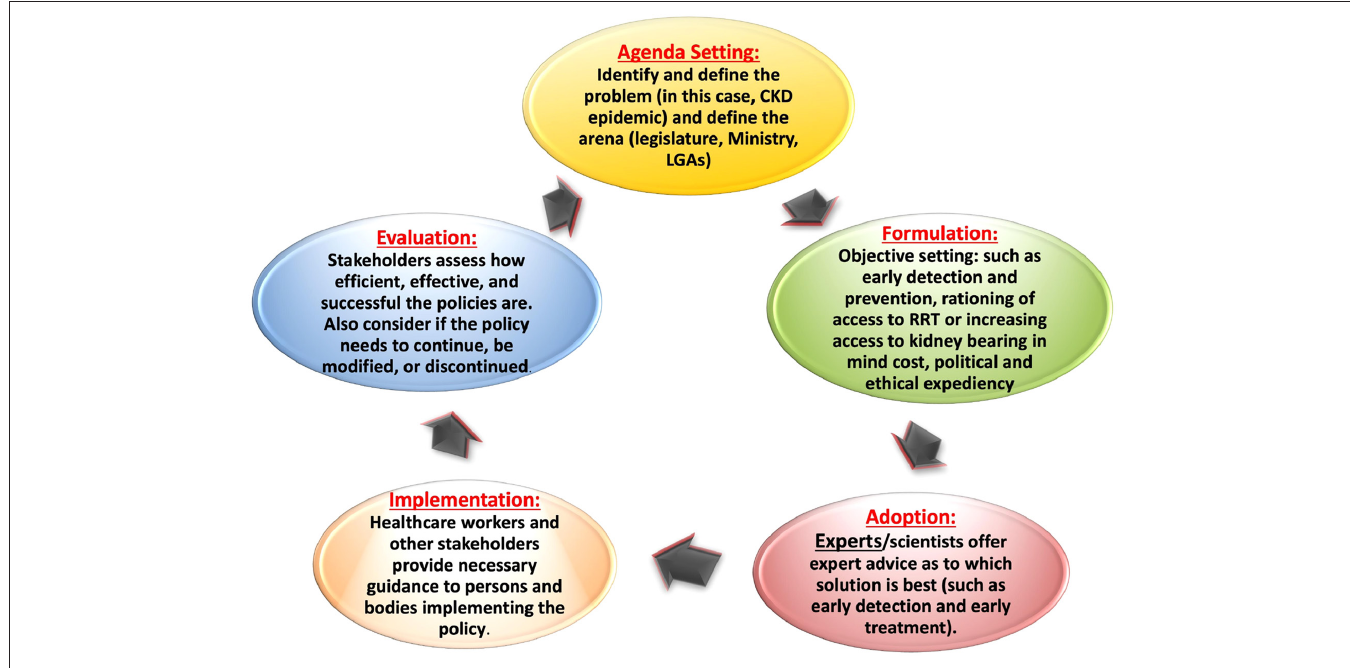
Figure 2. Policy cycle involving 5 stages of policy development. CKD, chronic kidney disease; KRT, kidney replacement therapy; LGA, local government